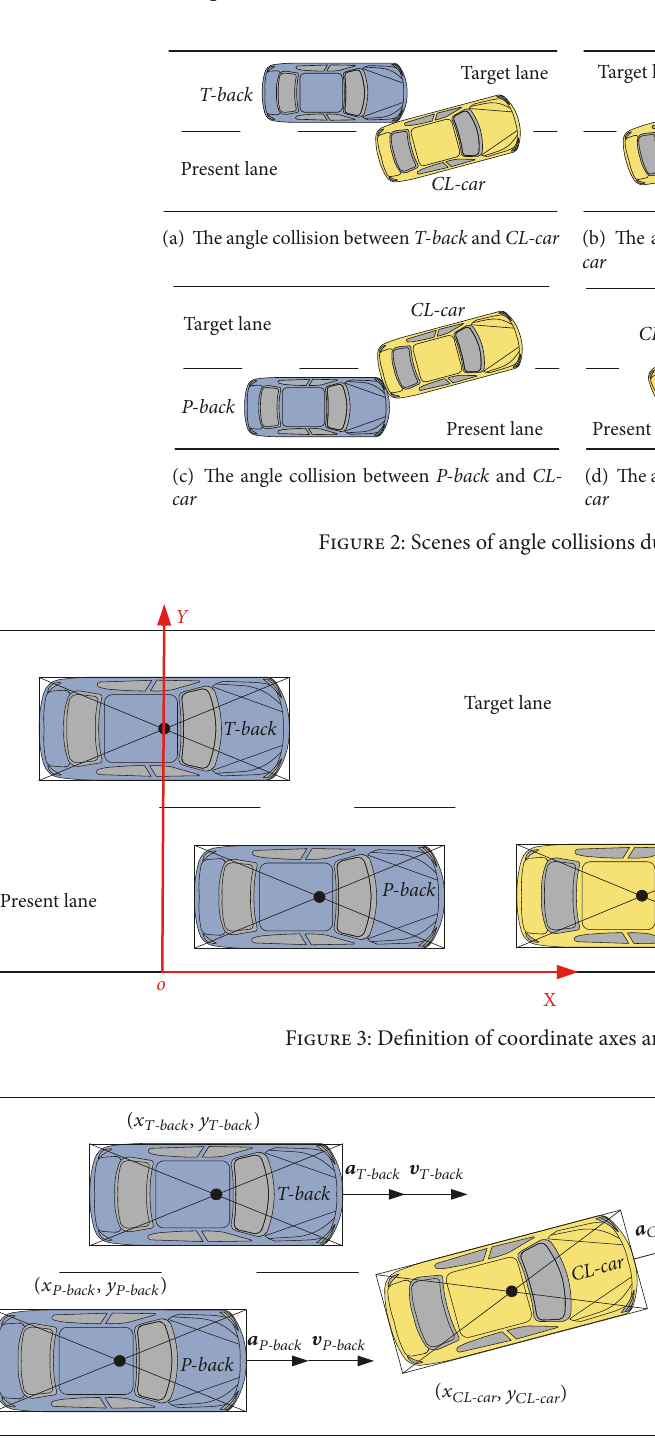
Figure 4: Lane change